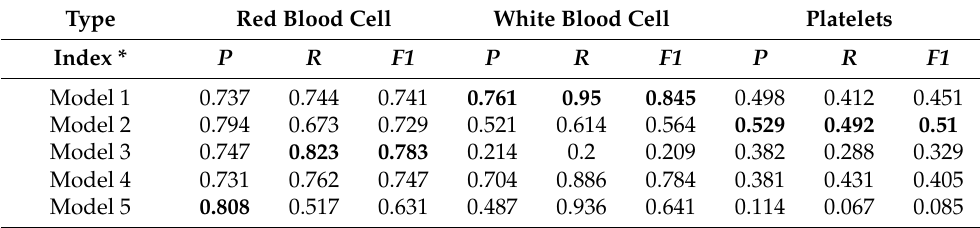
Table 4. Results of the validation data of all models when confidence score is 0.9.